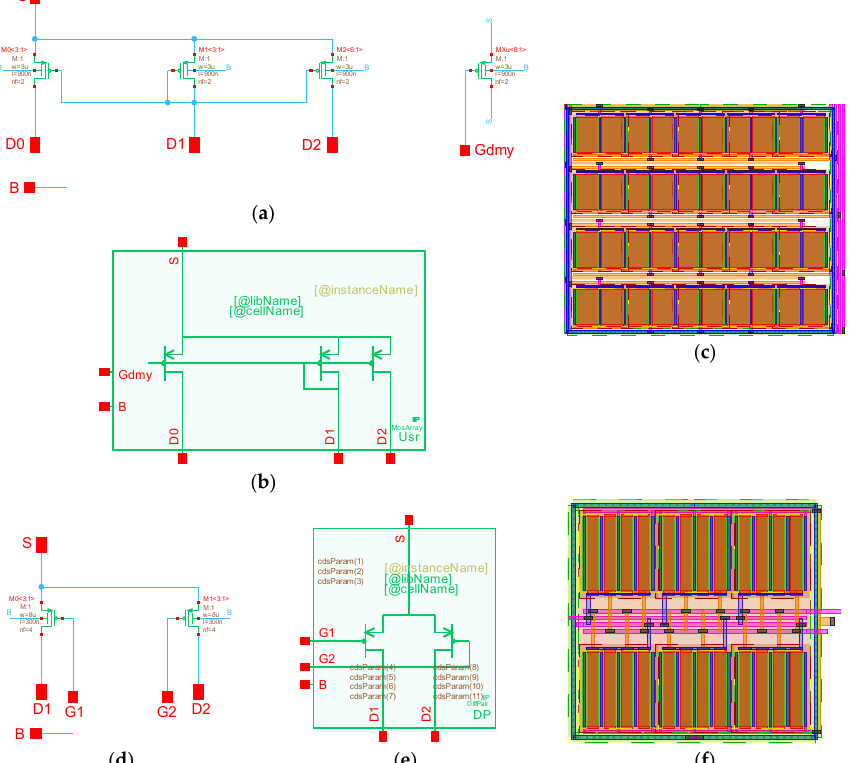
Figure 3. Examples of views of building blocks generated by procedural generators in a 22 nm technology (the views were converted to SVG files from original design data, thus, minor variations can appear). Above, the ( a ) schematic, ( b ) symbol, and ( c ) layout views of a current mirror with two branches and dummies are shown with a unit transistor sizing of two fingers, a width of 3 µm, and a length of 900 nm. Below, a differential pair is depicted in ( d – f ), respectively without dummies and unit devices with four fingers, a width of 8 µm, and a length of 300 nm, each.